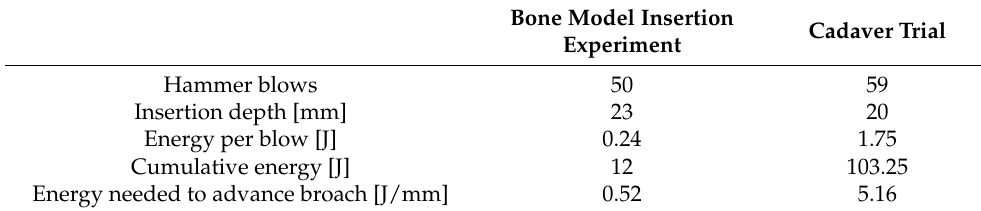
Table 4. Comparison between the in vitro bone model vs. in situ cadaver